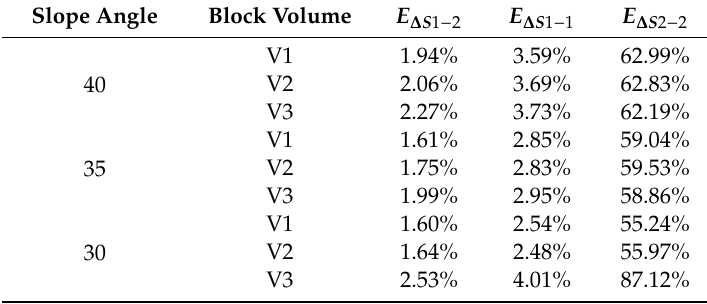
Table 5. Energy consumption mode during the interaction process between surge2 and the dead zone formed by